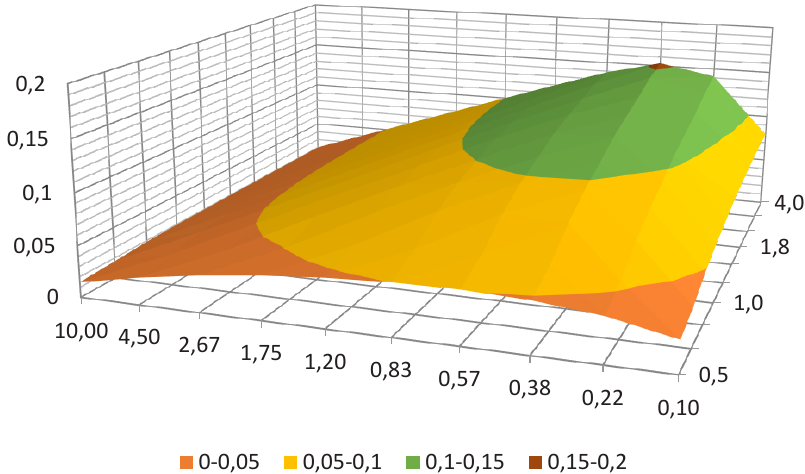
Figure 3. Dependence on elasticity (alpha) and the ratio of labor costs and capital W K with the equality of labor and capital intensity